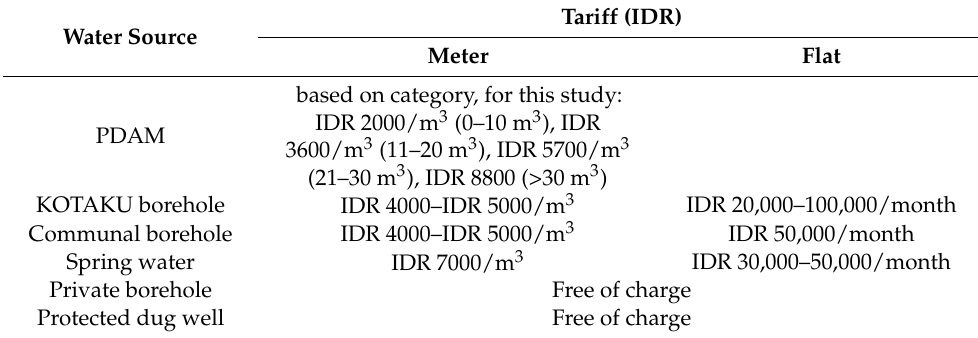
Table A1. Water tariff of different water sources in the study